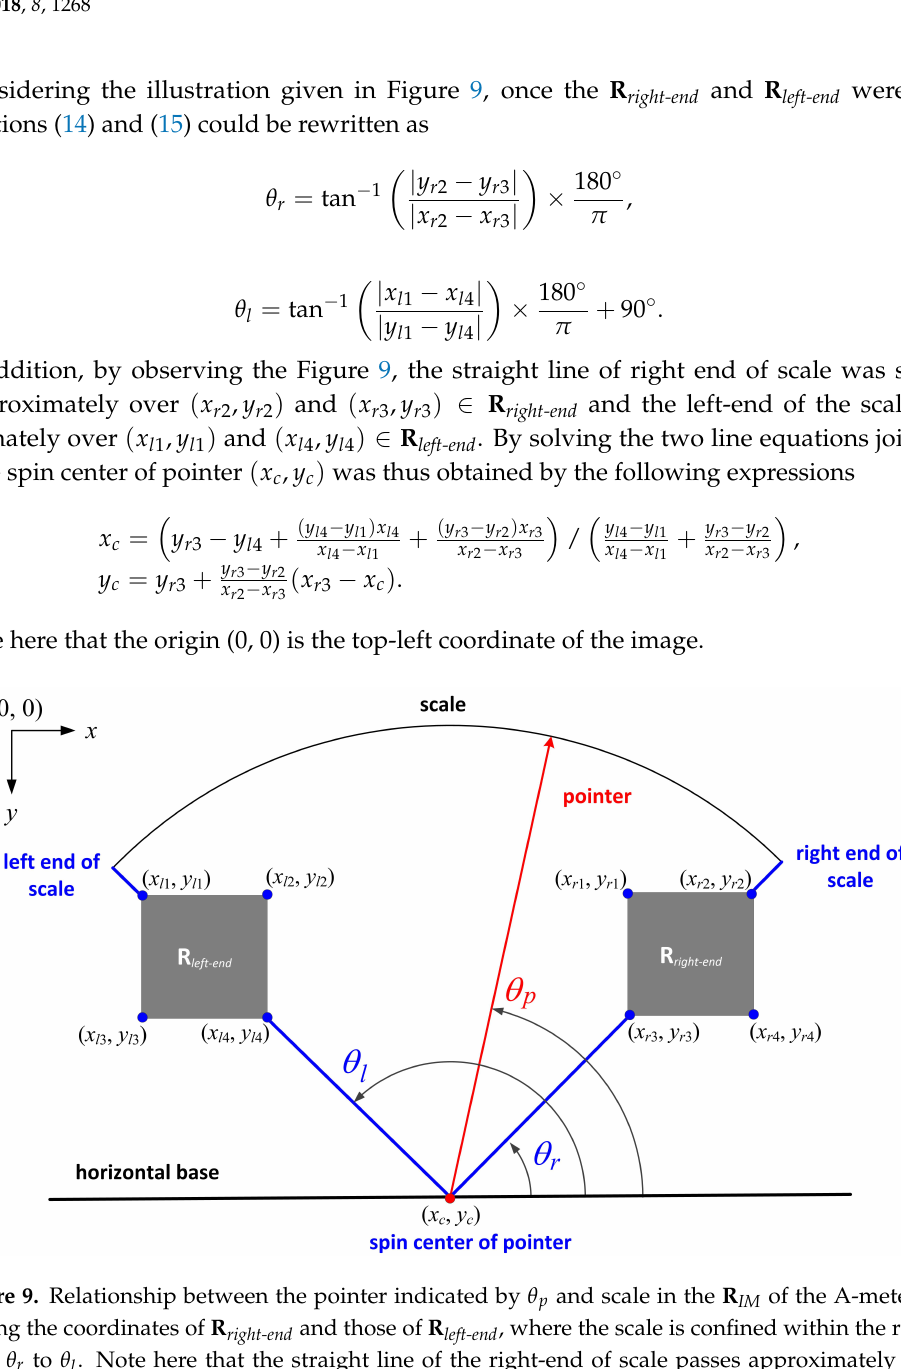
( x ) and l 1 , y l 1 ( x c , y c ) . The origin